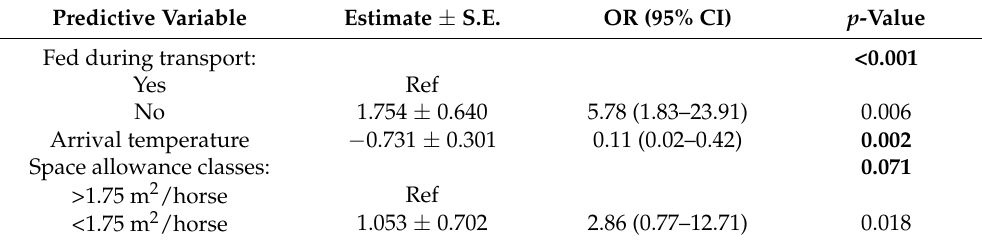
Table 15. Final multiple regression model for the dummy dependent variable of presence/absence of nasal discharge 24 h after unloading. Data are presented as estimate, standard error (S.E.), odds ratio (OR), confidence interval (95% CI), and p